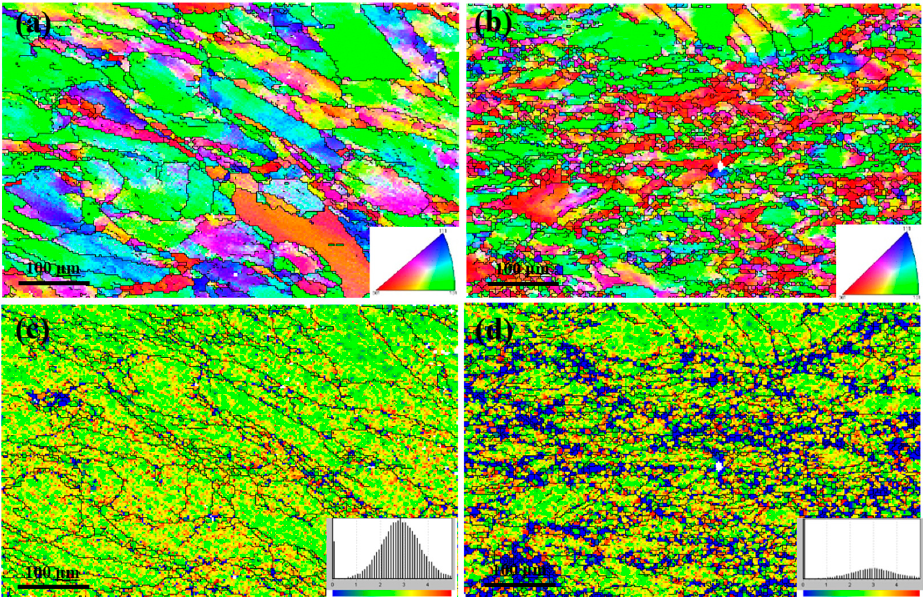
Figure 7. EBSD-IPF and corresponding KAM maps of the new type of Cu-1.1–Ni-0.7–Co-0.45–Si-0.3Cr alloy in different deformation states: ( a , c ) 600 °C and 0.01 s − 1 , ( b , d ) 800 °C and 0.01 s − 1 .